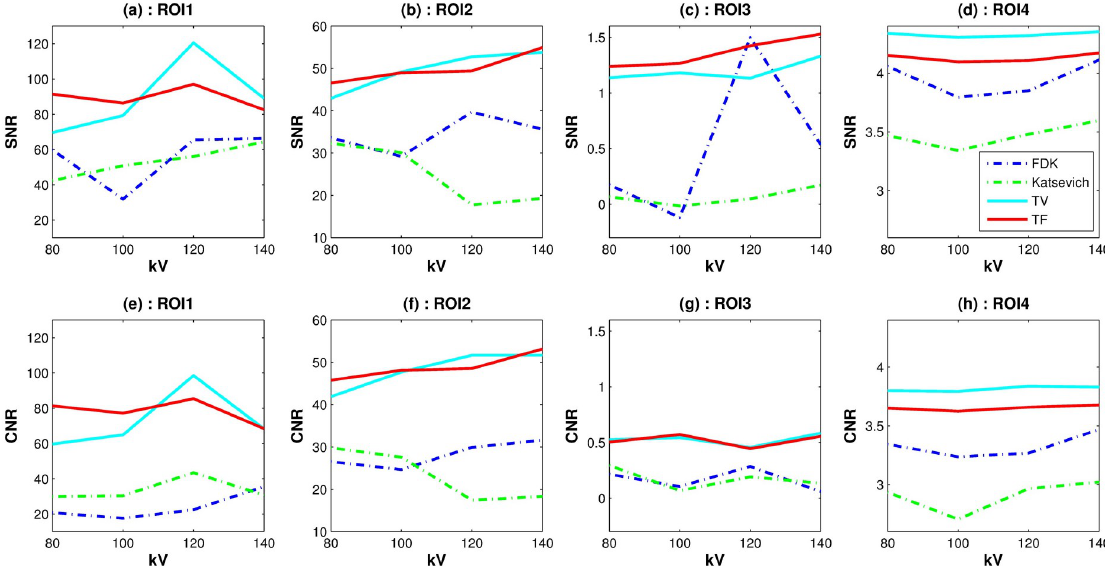
Fig 4. Image noise measures: Plots of SNRs(top row) and CNRs(bottom row) with the different reconstruction algorithms over various voltage levels. The x -axis is the dosage level in kV.